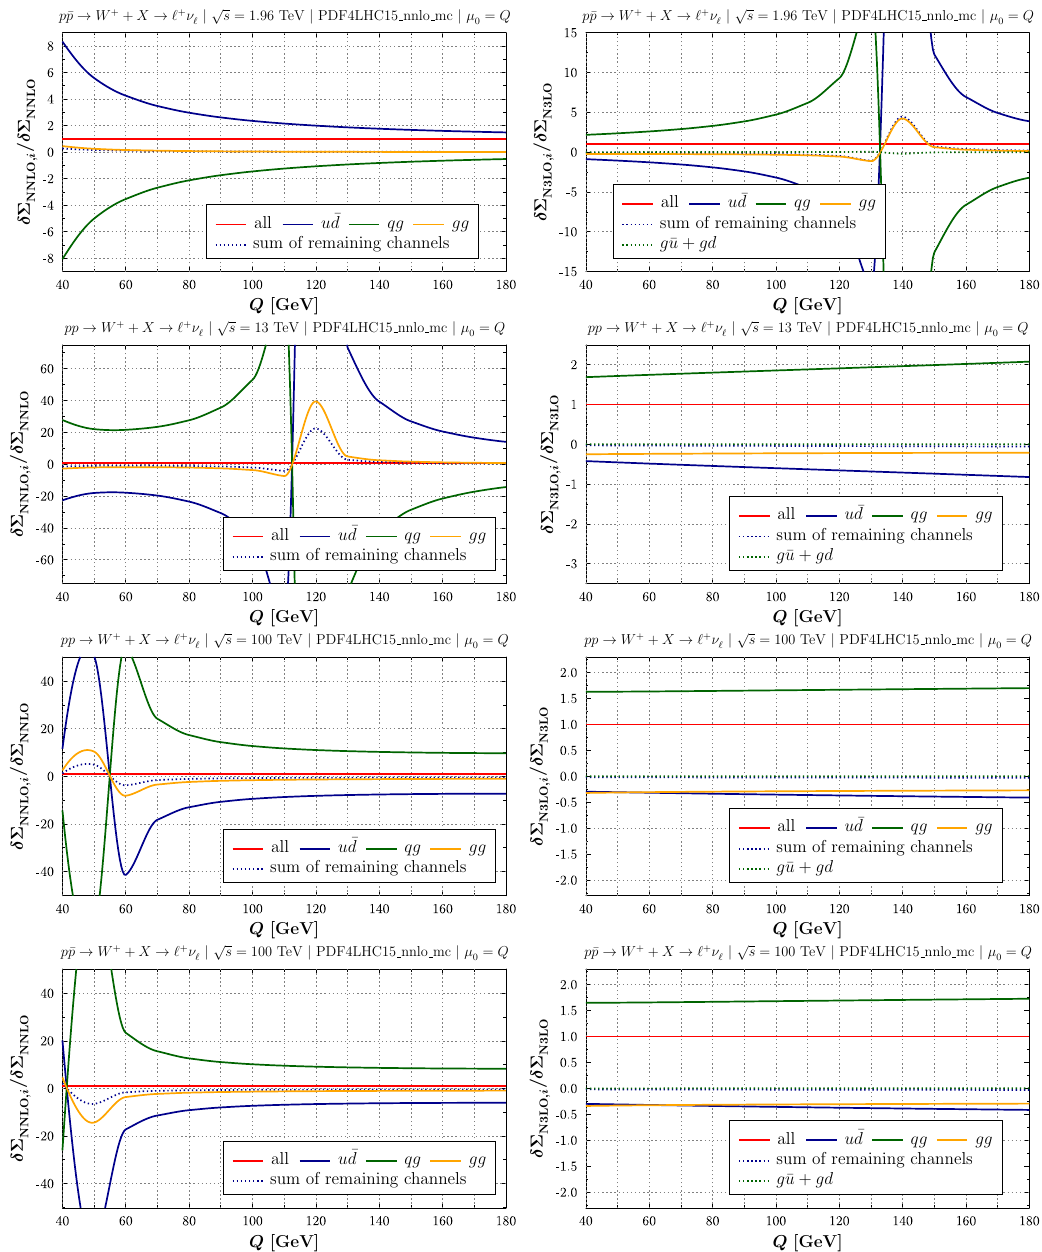
Figure 8 . Individual channels contributing to the invariant mass distribution for the production of an e + ν pair at different colliders normalized to the total correction at NNLO (left panels) and e N 3 LO (right